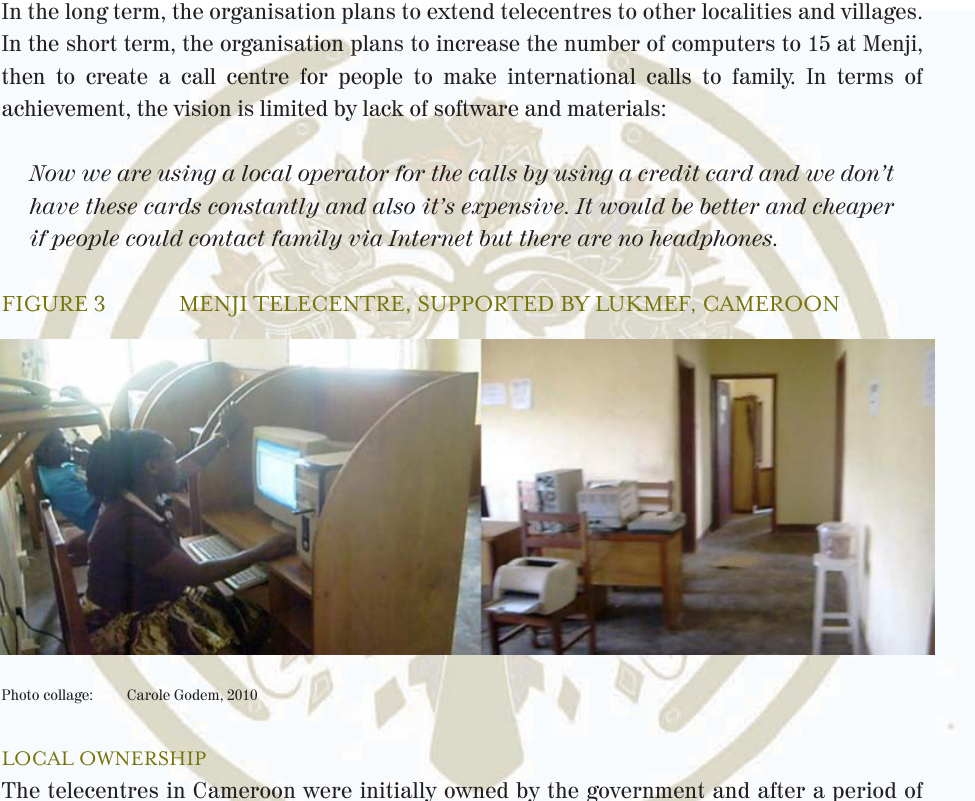
MENJI TELECENTRE, SUPPORTED BY LUKMEF,